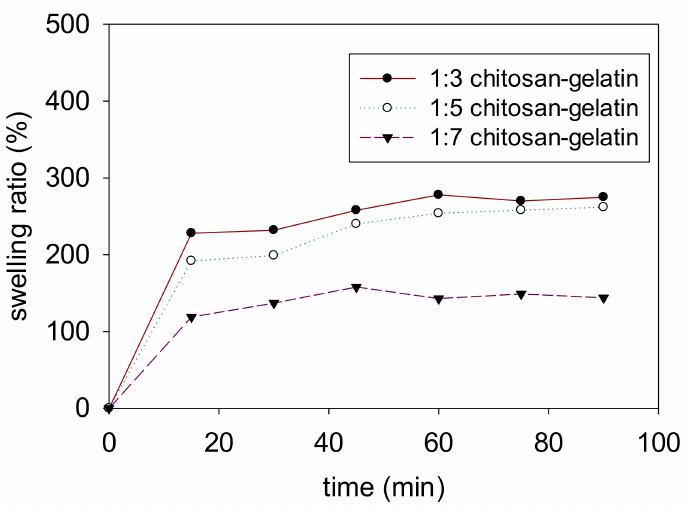
Figure 8. Swelling ratio percentage of the membrane with different composition ratios in pure